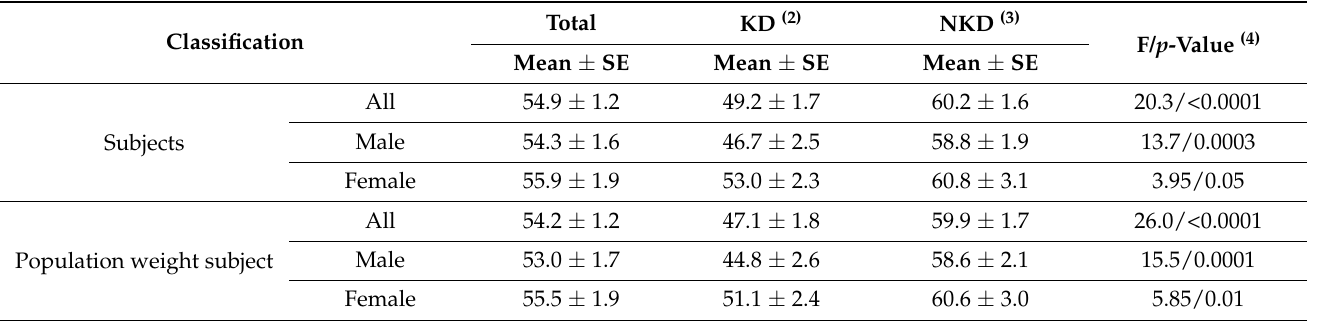
Table 4. Comparison of the kidney and the non-kidney disabled QOL (EQ-VAS) (1) by ANCOVA in five-year KHP pooled data.